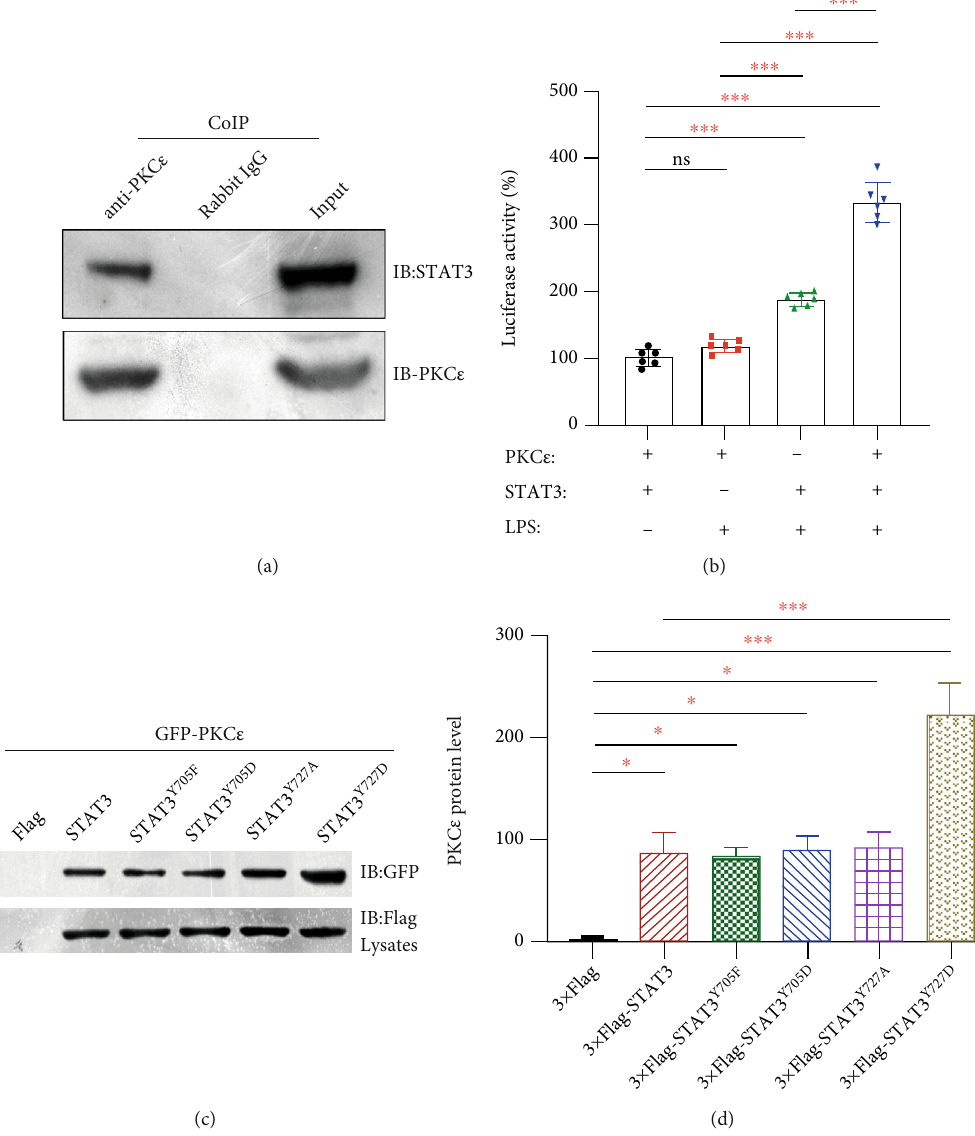
Figure 7: Ser727 of STAT3 increased its interaction with PKC ε . (a) Endogenous PKC ε was immunoprecipitated from cell lysates, and immune complexes and total cell lysates were analyzed by Western blot analysis with PKC ε and STAT3 antibodies. Endogenous immune PKC ε /STAT3 complexes were detected in the rat spinal cord tissues. (b) IL-6 promoter- fi re fl y luciferase reporter plasmid (0.5 μ g), PKC ε (1 μ g), and STAT3 (1 μ g) were cotransfected overnight into HEK293 cells. The transfected cells were incubated with 1 μ g/mL lipopolysaccharide (LPS) for 12h. Interleukin-6 promoter activity increased by STAT3 was further enhanced by PKC ε and STAT3, indicating that PKC ε improved the ability of STAT3 to bind to IL-6 promoter. Data are shown as means ± SD ( n = 6 ). ∗ P < 0 : 05 , ∗∗ P < 0 : 01 , ∗∗∗ P < 0 : 001 ; one-way ANOVA followed by Bonferroni tests. (c, d) HKE293 cells were transfected with GFP, GFP-PKC ε , Flag, Flag-STAT3, and phosphomimetic and dephosphomimetic mutants of STAT3, and then, immunoprecipitants were assayed. Protein complexes were detected using an anti-GFP antibody (c), and then, relative PKC ε binding to STAT3 was quanti fi ed (d). Data are presented as means ± SD ( n = 3 ). ∗ P < 0 : 05 , ∗∗ P < 0 : 01 , ∗∗∗ P < 0 : 001 ; one-way ANOVA followed by Bonferroni